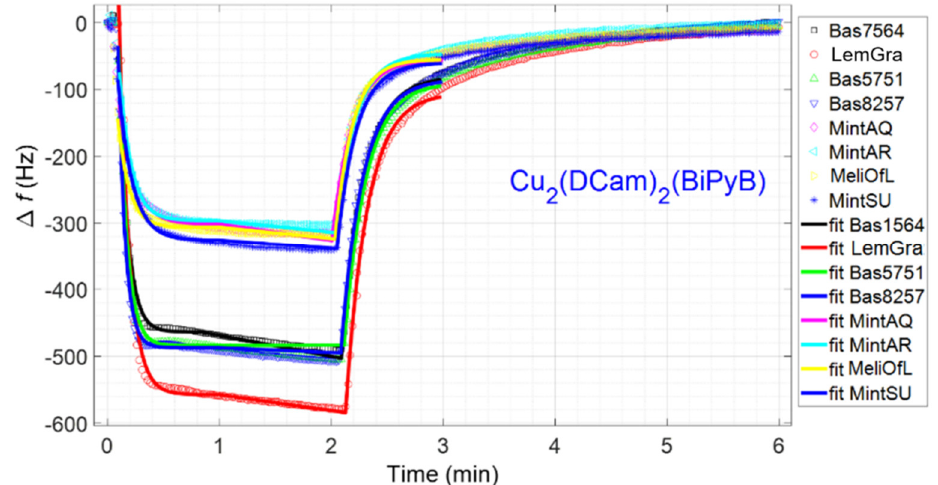
Figure 4. An example illustration of a one-cycle response of the sensor array, the change in resonance frequency of the sensing film Cu 2 (DCam) 2 (BiPyB) due to adsorption with 2 min exposure, and subsequent 4 min purging during cleaning with dry N 2 gas.